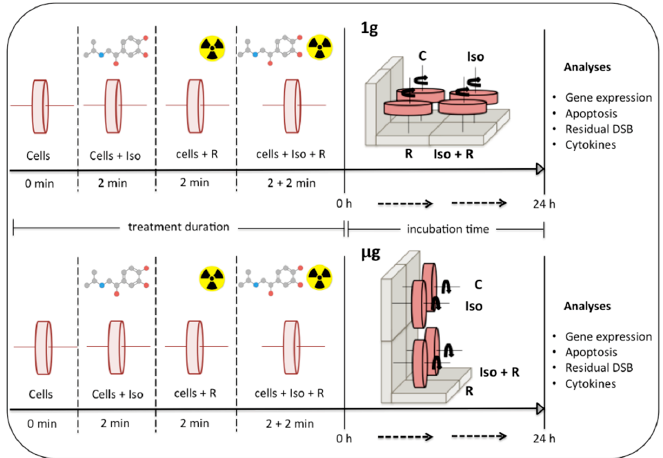
Figure 6. Schematic representation of the treatment conditions. Cells were distributed in eight RCCSVs. Isoproterenol treatment (Iso) and radiation exposure (R) were performed separately and in combination (Iso + R). For the combined treatment, cells were irradiated for 2 min immediately after 2 min isoproterenol (Iso) treatment. Vessels were placed in an incubator and rotated at 8.5 rpm on a vertical (Earth gravity = 1 g ) or on a horizontal axis (simulated microgravity = µg). Vessels with nontreated cells (C) were incubated in 1 g and in µg. After 24 h cells were recovered from the vessels and analyses were performed (DSB = DNA strand breaks).